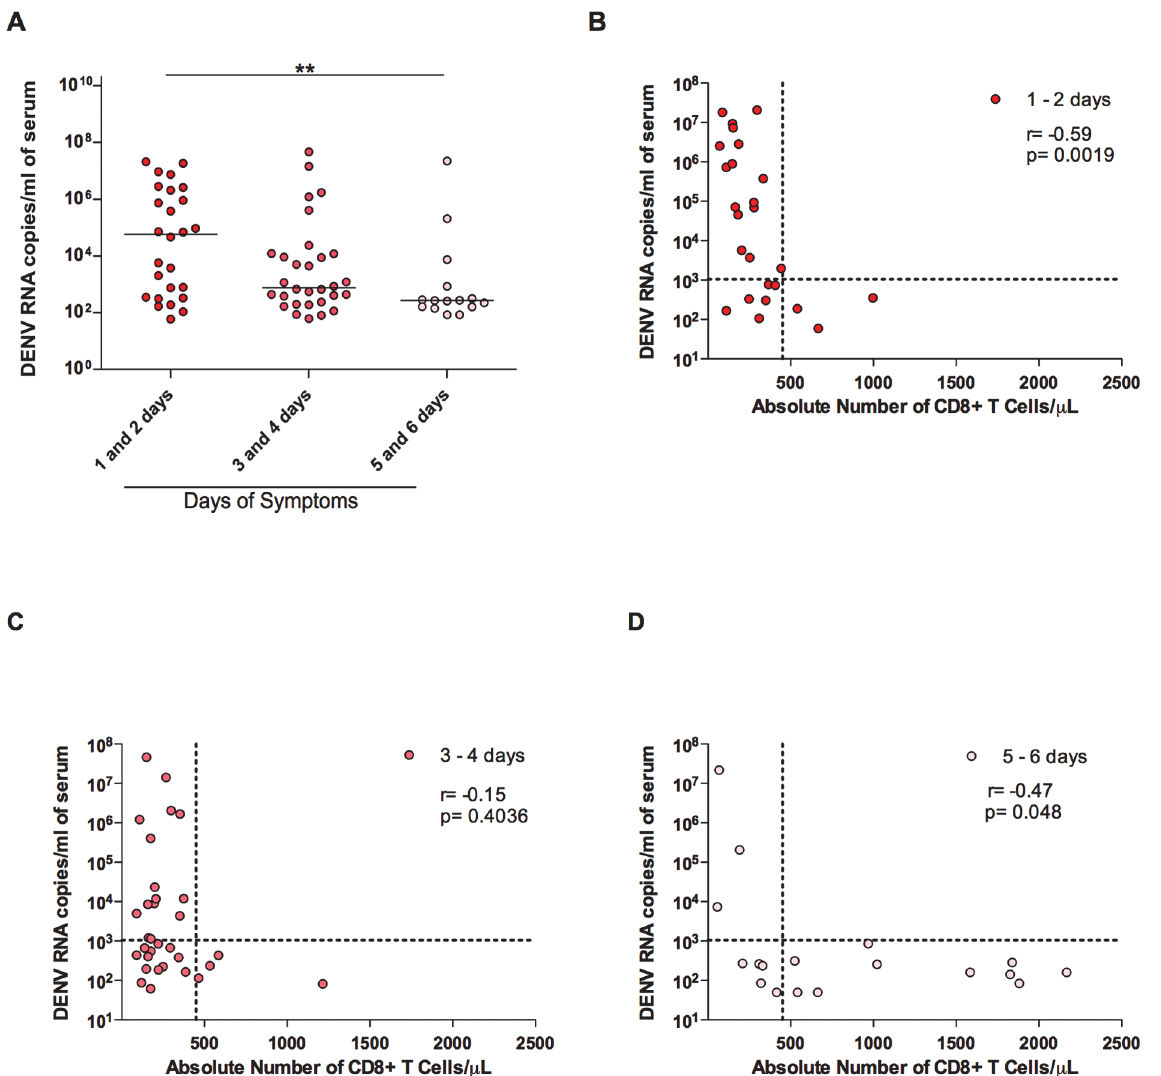
Fig 2. Correlation of CD8+ T lymphocyte numbers and DENV viral load. In A, viral load was determined on different days of symptoms and a significant decrease was observed in days 5 and 6 when compared to days 1 and 2 after the onset of symptoms (p value = 0.0136). In B, a negative correlation was observed between 1 and 2 days of symptoms (r = -0.5900, p = 0.0019). There is no correlation between 3 and 4 days of symptoms (C) and viral loads; In D, a negative correlation was observed between viral loads and 5 and 6 days of symptoms (r = - 0.4705, p = 0.0488). Dashed lines are arbitrarily set at 450 CD8+ T lymphocytes/ μ L and 1050 copies of